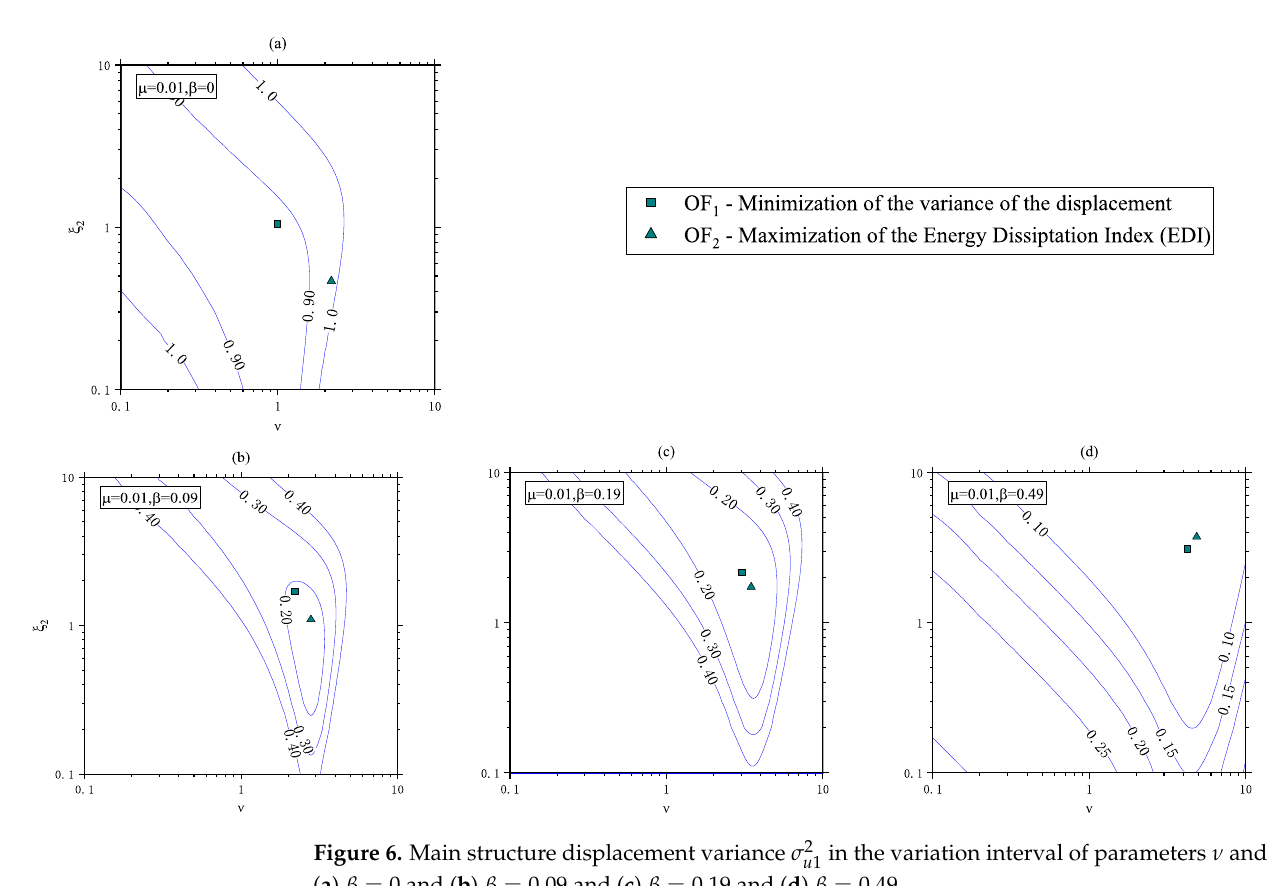
Figure 6. Main structure displacement variance 𝜎 (cid:3048)(cid:2869)(cid:2870) in the variation interval of parameters 𝜈 and 𝜉 (cid:2870) . (a) 𝛽 = 0 and (b) 𝛽 = 0.09 and (c) 𝛽 = 0.19 and (d) 𝛽 = 0.49.